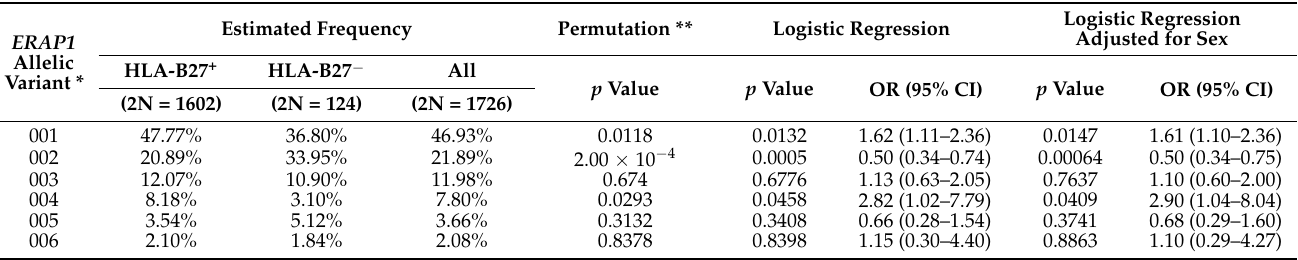
Table 2. Association of ERAP1 allelic variants with HLA-B27 positivity among Taiwanese AS patients stratified by HLA-B27 status.